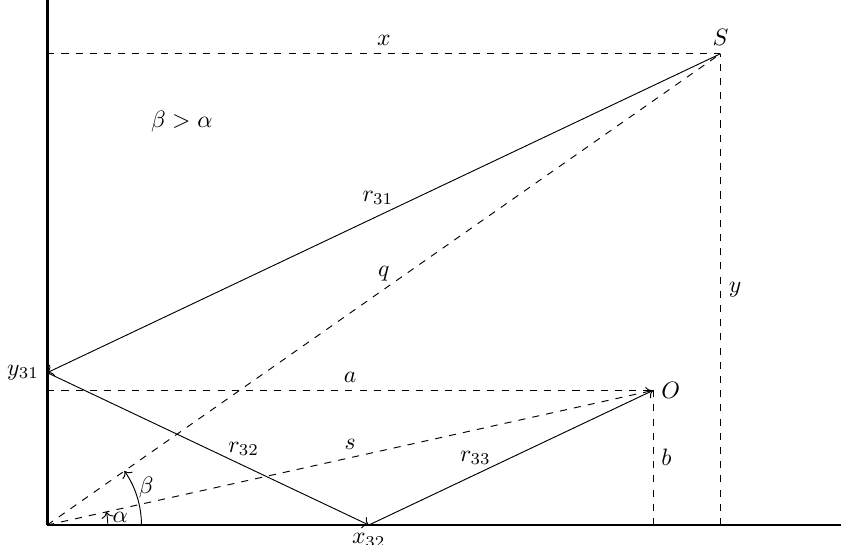
Figure A1: The same as the Figure 2, but with the difference that the elevation angle β for the source is larger than for the observer α , that is, α < β , showing again the double reflection path as the Figure 2, where in this case the first reflection is on the wall and the second reflection is on the ground.